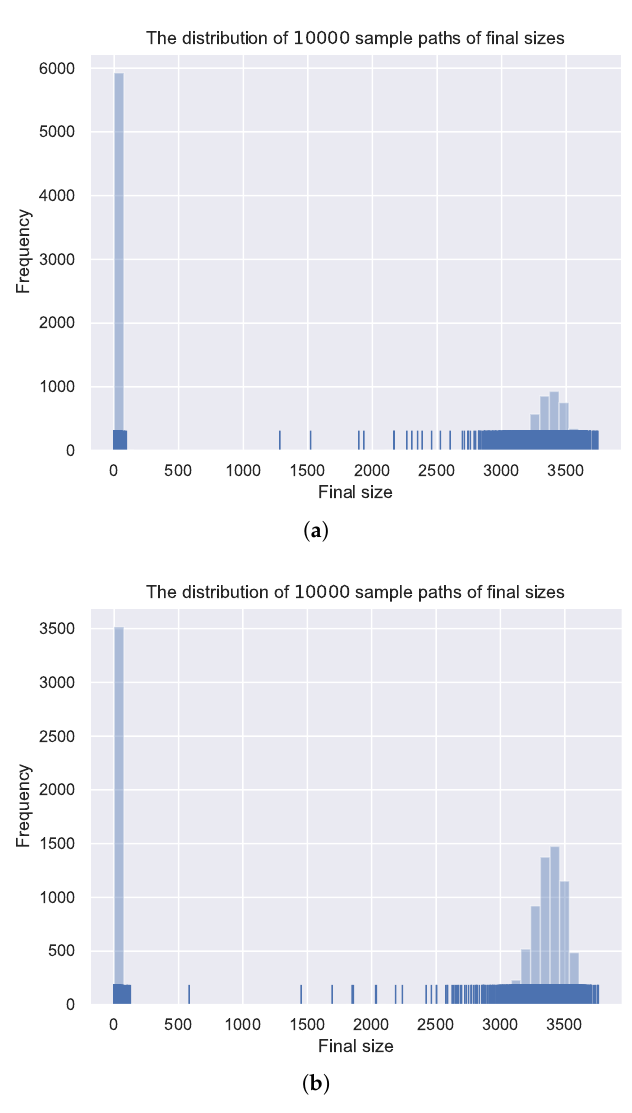
Figure 5. The distributions of the final epidemic sizes for delayed stochastic epidemic model (1) (simulated with DSSA), initiated by one infectious individual (in ( a )) and two infectious individuals (in ( b )), respectively. The distributions are bimodal and are both sparse for the region in between. The third set of numerical simulations is to generate 10 4 realizations for the approxi- mated CTMC epidemic models (3) with with n = 1, 2, 5, 10. The initial condition is I ( 0 ) = 1. Probabilities of a minor outbreak for stochastic epidemic models are indicated by